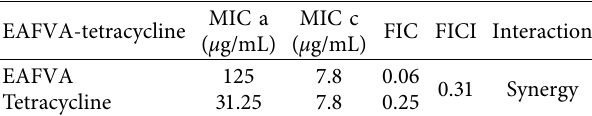
Table 4: MIC alone value and MIC combination value of EAFVA with the combination interaction on P.aeruginosa